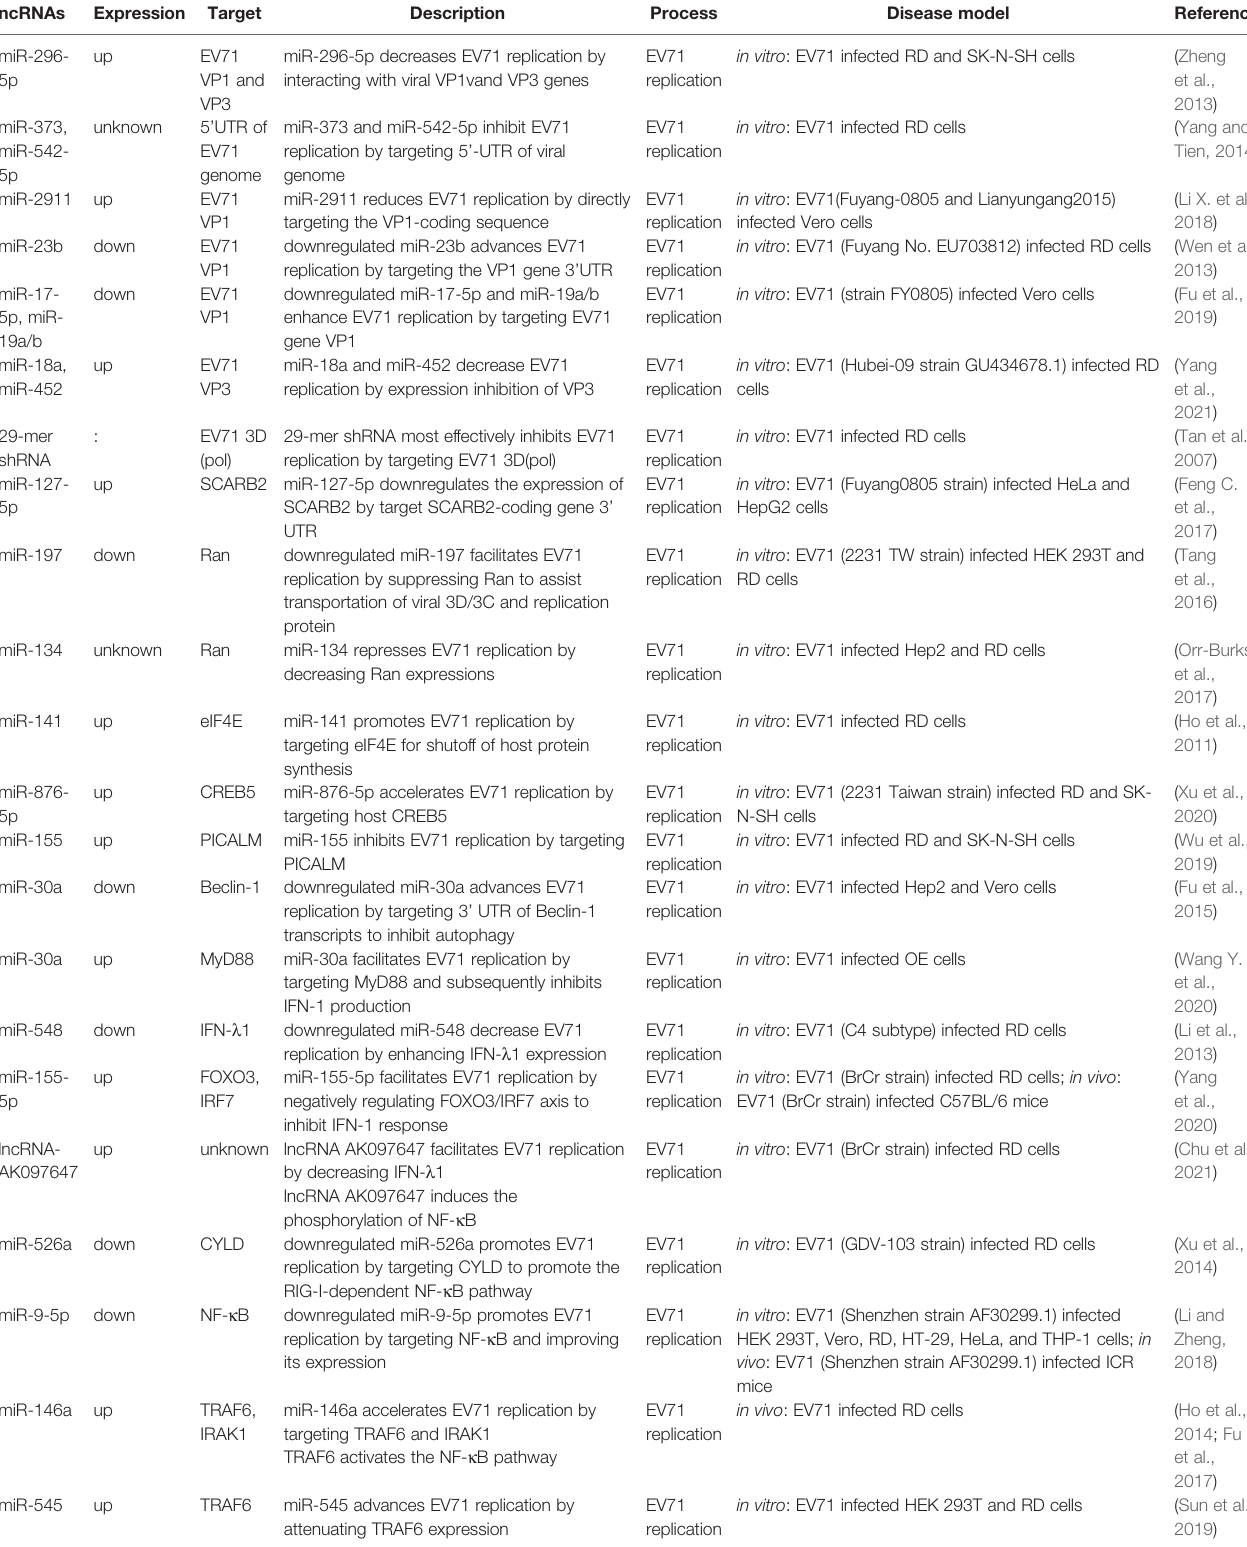
TABLE 1 | ncRNAs involved in EV71